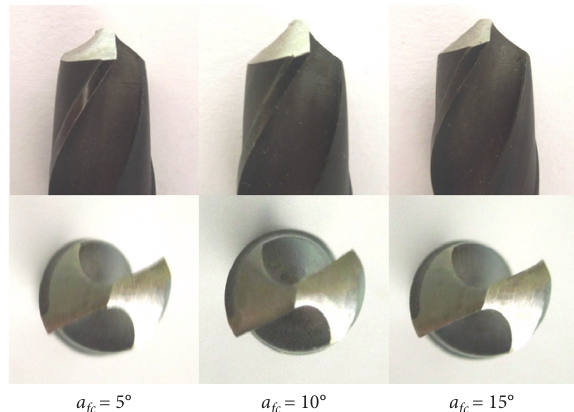
Figure 12: The shape of blade-grinded drills.